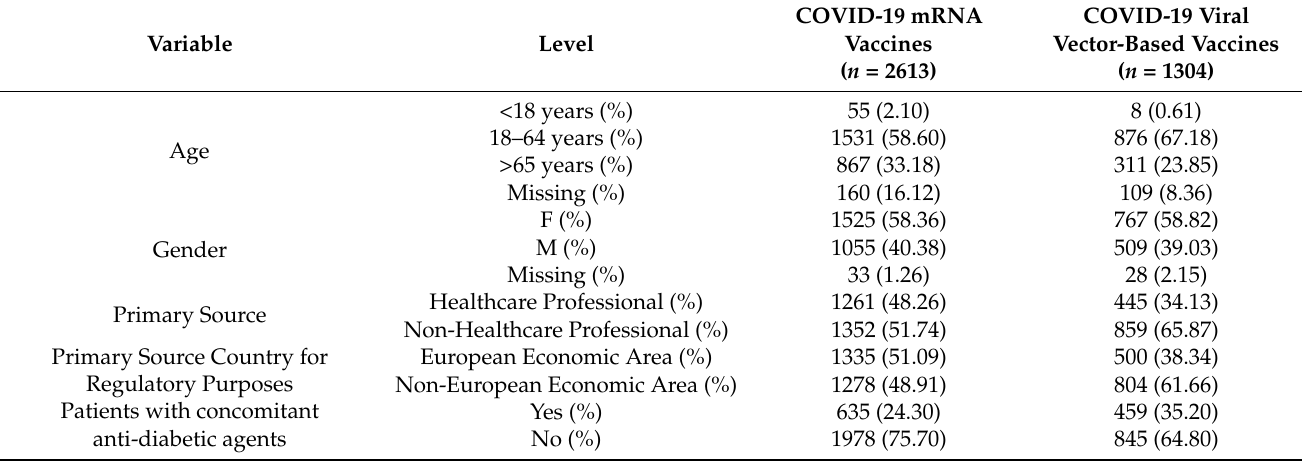
Table 1. Distribution for age, gender, primary source, primary source country, presence of concomi- tant anti-diabetic agents among Individual Case Safety Reports (ICSRs) reporting at least one event of impaired glucose metabolism and having mRNA or viral vector COVID-19 vaccines as suspected vaccine among those reported in Eudravigilance from 1 January 2021 to 11 December